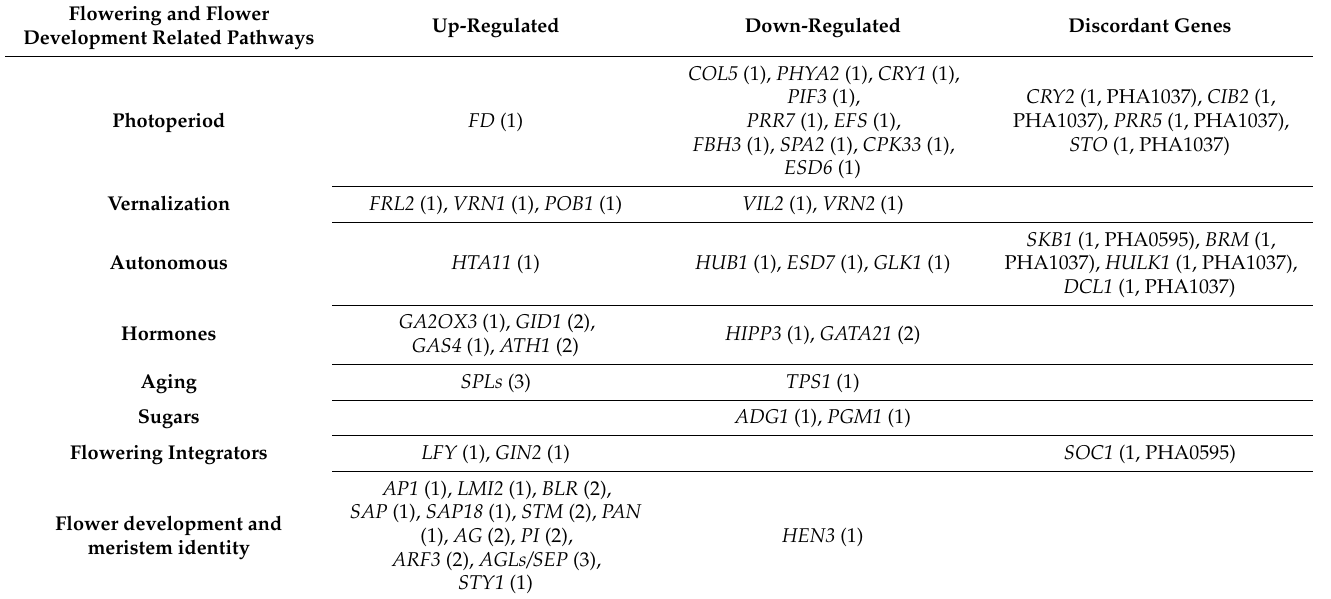
Table 1. Summary of the 66 evolutionarily conserved genes included in the FLOR-ID Arabidopsis flowering